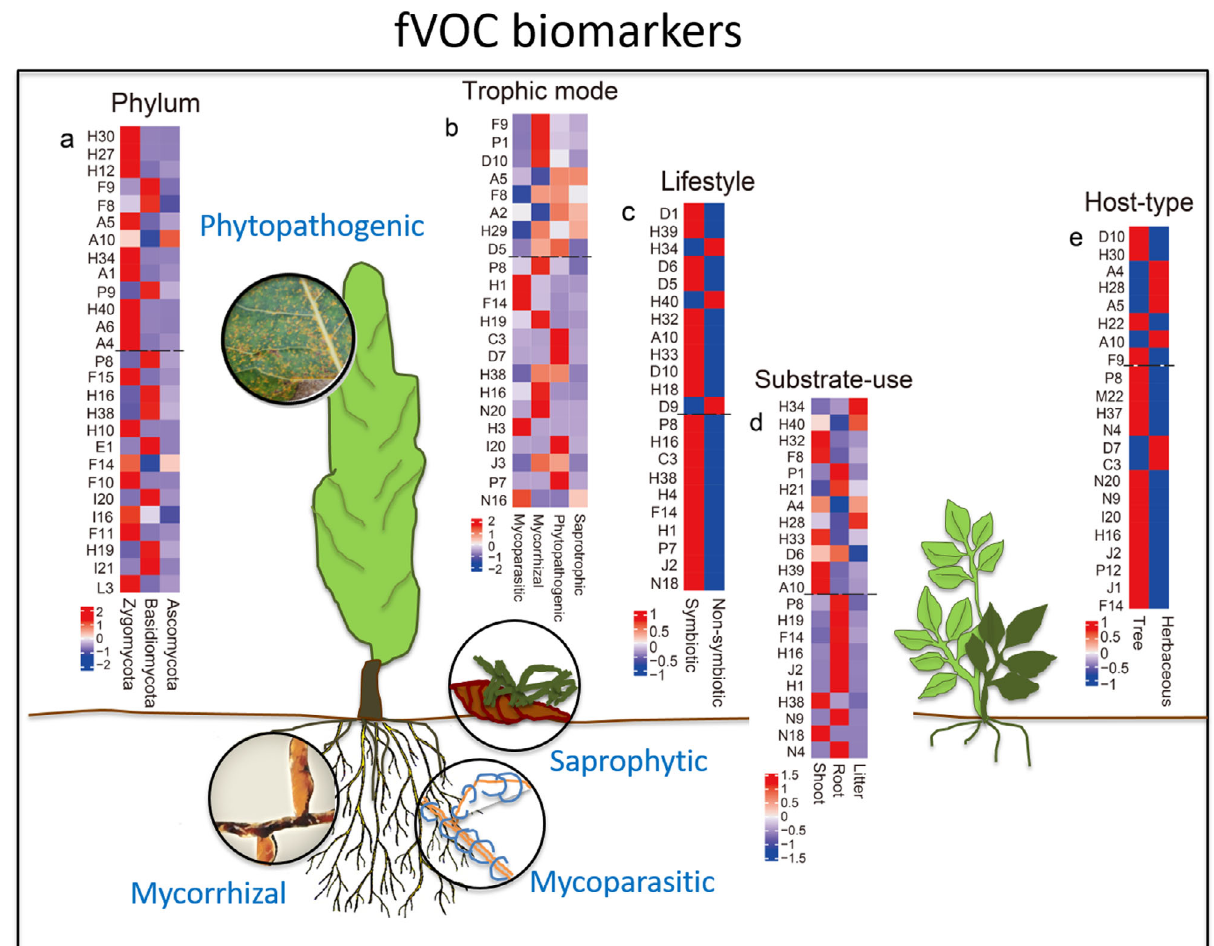
Fig. 6 Volatile biomarkers identi fi ed for phylum, trophic mode, (non)symbiotic lifestyle, substrate-use, and host type. The dashed line dividing the heatmap separates compounds detected by PTR-ToF-MS (upper part) and GC – MS (lower part) ( a – e ). The compounds are shown in descending order according to its importance from top for PTR-ToF-MS (upper part) and GC – MS (lower part), respectively. The color code refers to the emission intensity (data show z -scores). The letters refer to the compounds listed in Supplementary Tables S2 and S3 51 . The schematic tree and soil scenario illustrate the natural plant – fungi interaction contexts; photo: J-P